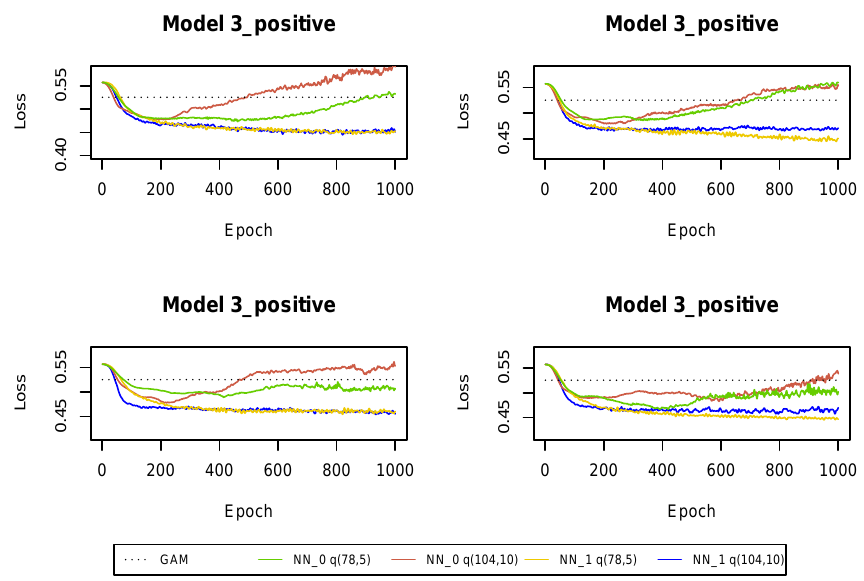
Figure A17. Deviance loss functions on validation sets observed during the training of the neural networks in k =